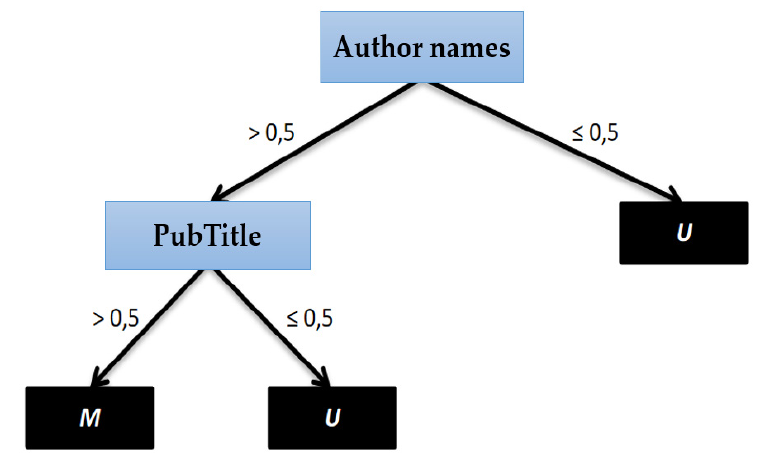
Figure 6. Decision tree for record linkage.